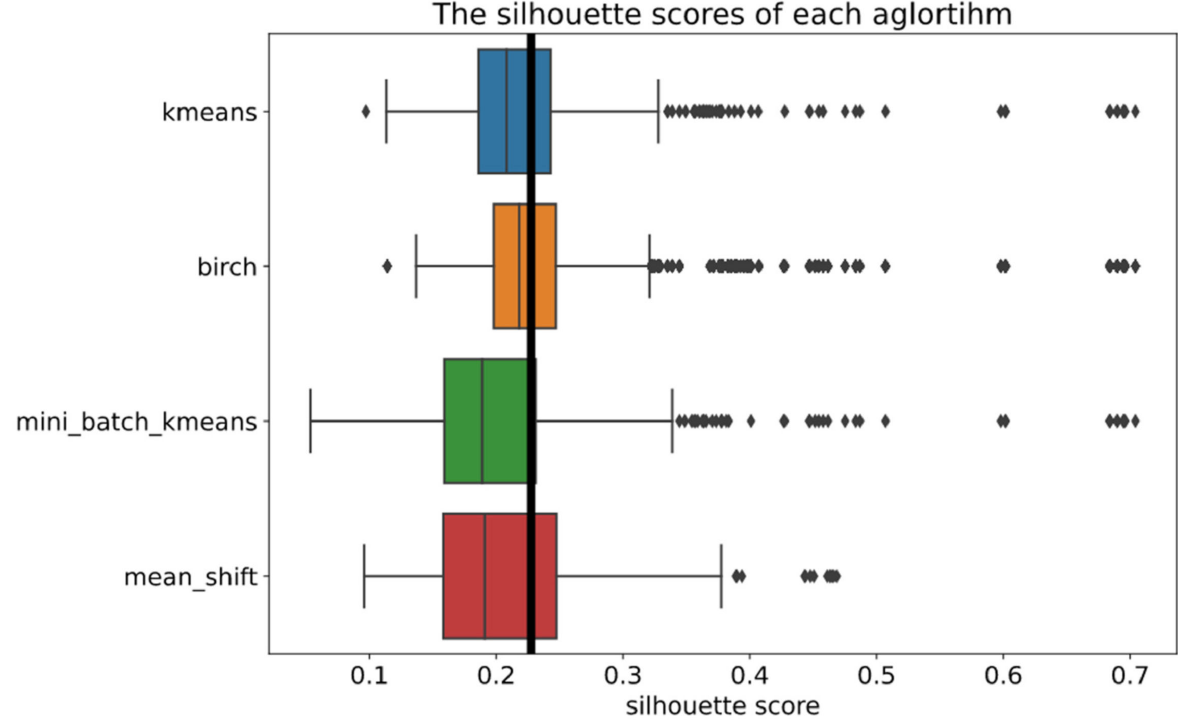
Figure 5. Silhouette score box plots of initial clustering methods. The black line indicates the mean silhouette score using all